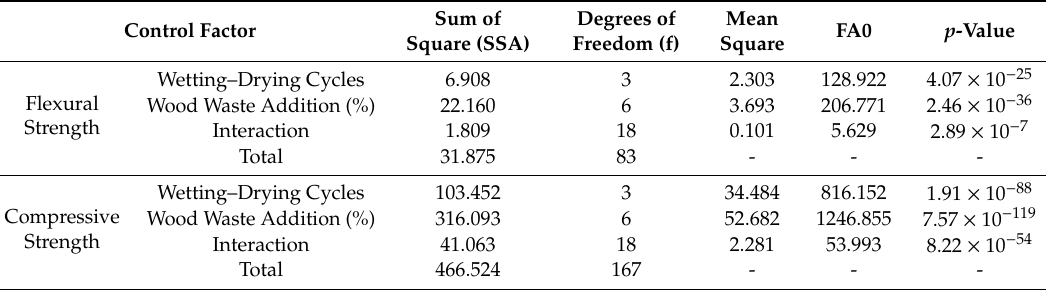
Table 5. Results of ANOVA for the flexural and compressive strength test results. Influence of wetting–drying cycles, type and percentage of wood waste added, and the interaction of both factors.